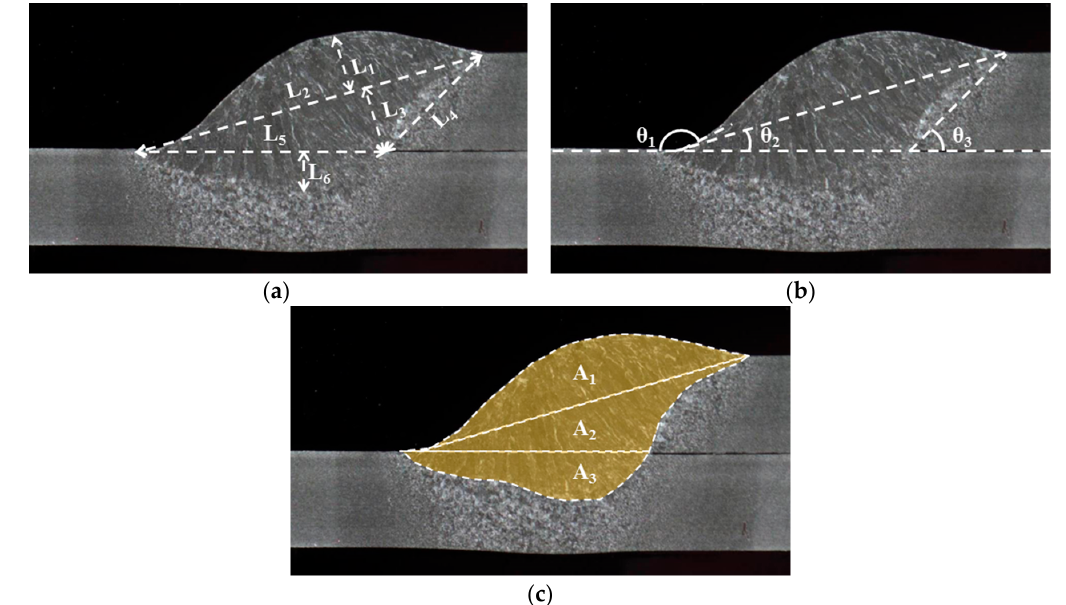
Figure 9. Configuration of the weld bead by ( a ) length, ( b ) angle and ( c ) area.